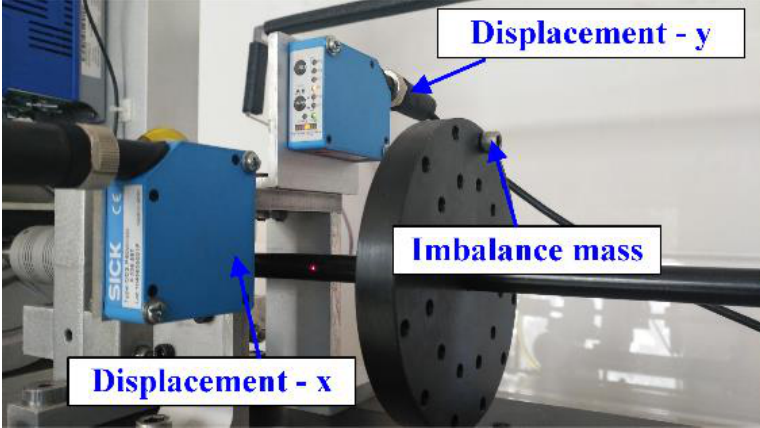
Figure 9. The detail of the displacement sensor. Table 4. The parameters of the imbalance mass.